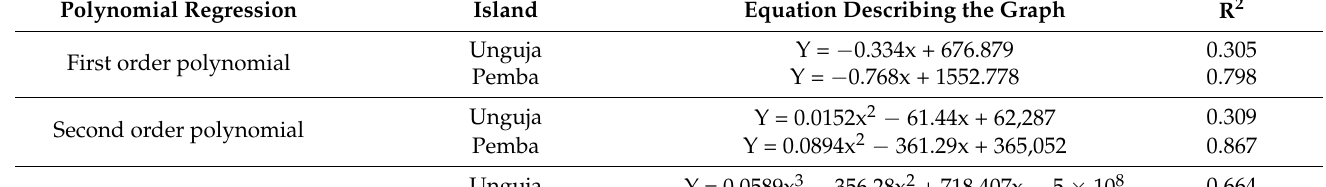
Table 2. Polynomial regression of schistosomiasis prevalence in two islands of Zanzibar according to year.